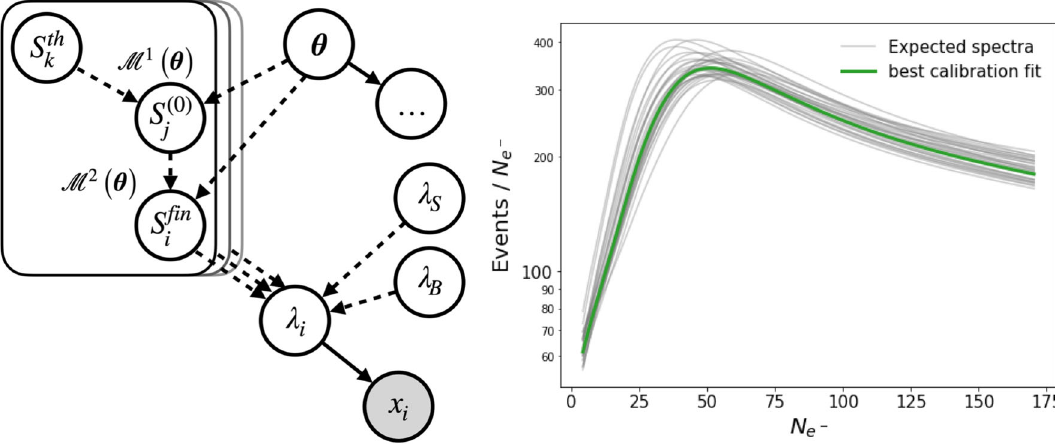
Fig. 2 Left: Bayesian network for a prototypical dual phase TPC DM direct detection experiment. The node x i is the observed number of events in the i -th bin; λ i is the intensity of the Poisson process in the i - th bin; λ S and λ B regulate the strength of the signal and the background contributions, respectively; the boxes in different gray intensities rep- resent the different contributions from all the relevant background or